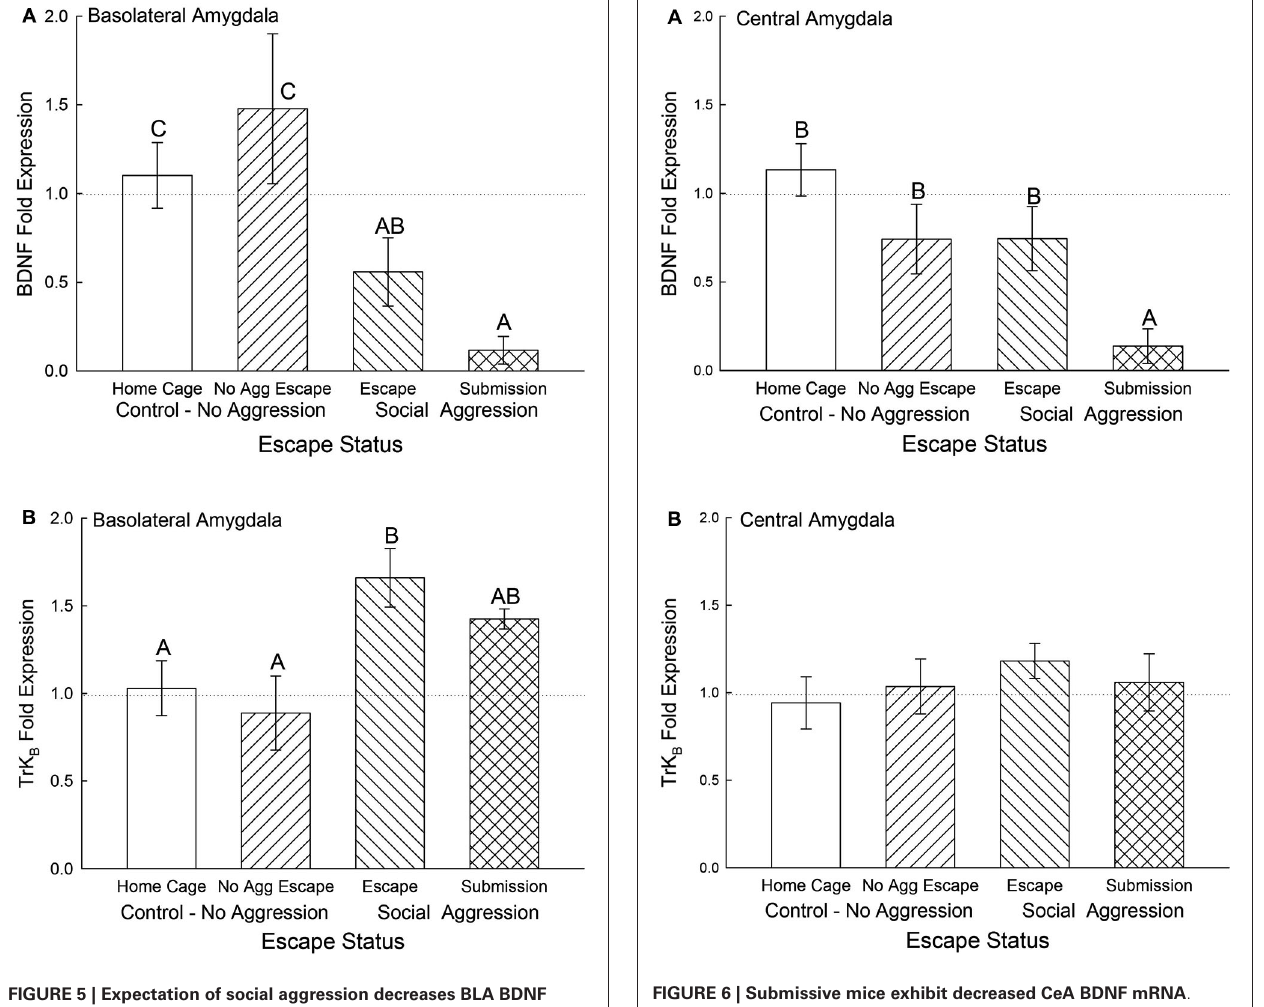
Other genes of interest in the BLA and CeA that were tested for all groups but resulted in no significant difference from controls were NPY, GluR 1 and GluR 4 . In the BLA, NPY ( F 2,21 = 1.4, p > 0.25; data not shown), GluR 1 ( F 2,19 = 1.42, p > 0.27), and GluR